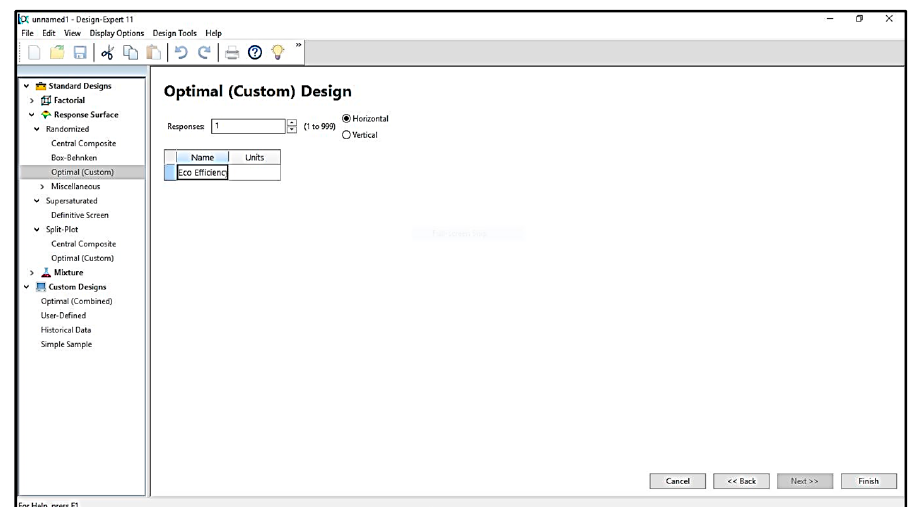
Figure 4. Determination Number of Response.